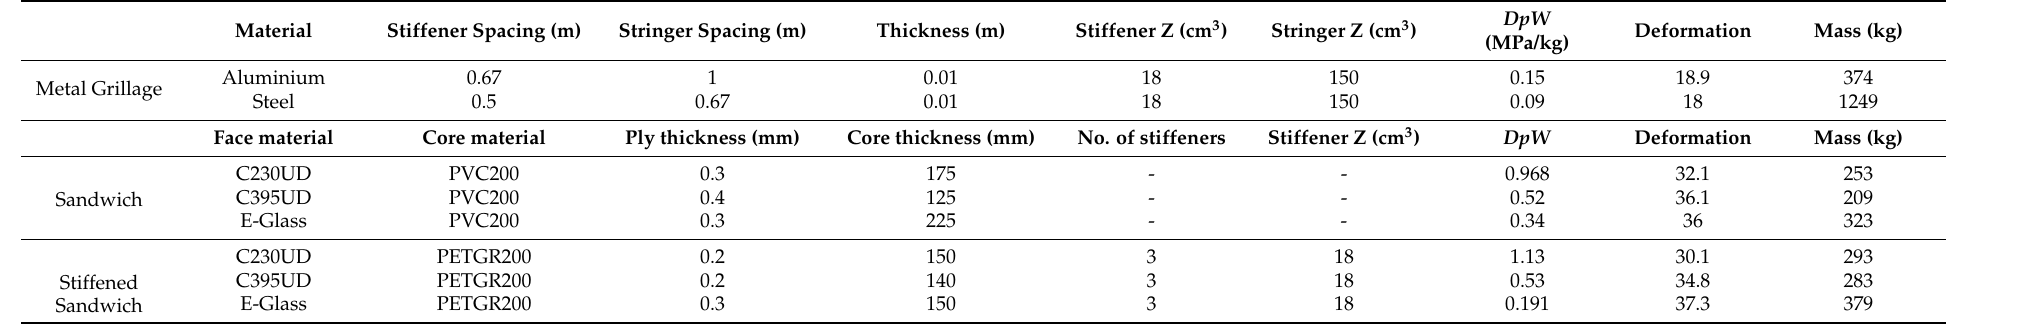
Table 8. Best parametric combinations by material in terms of DpW and